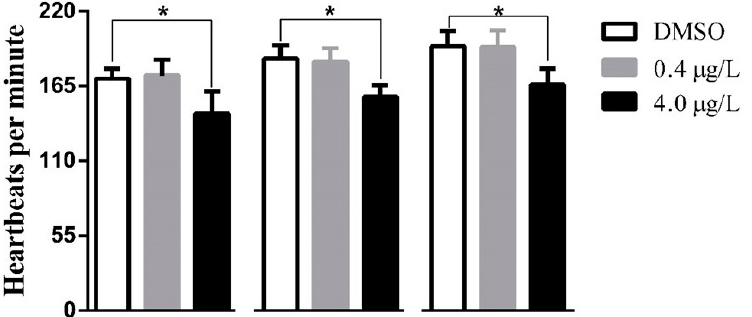
Figure 2. Bar graph showing mean heartbeats per minute observed at 48, 72, and 96 hpf. Results are presented as mean ± standard deviation ( n = 3). Unpaired Student’s t-test was performed for statis- tical analysis. * statistically significant ( p < 0.05).